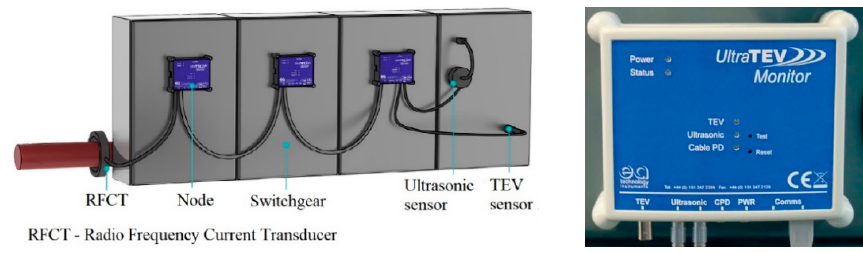
Figure 4. System layout of an UltraTEV Monitor System and an UltraTEV node [16] .